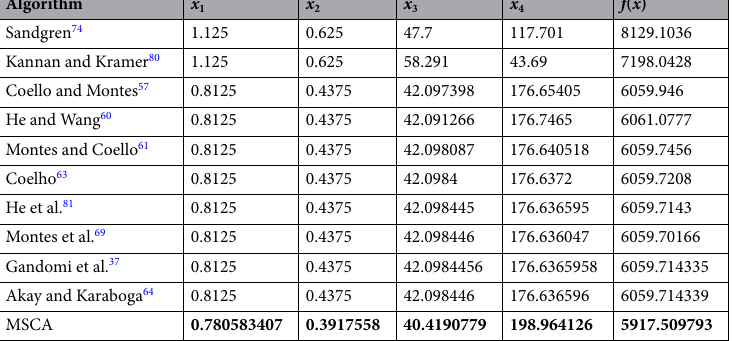
Table 21. The best solution for pressure vessel design problem on version I. Significant values are in bold.